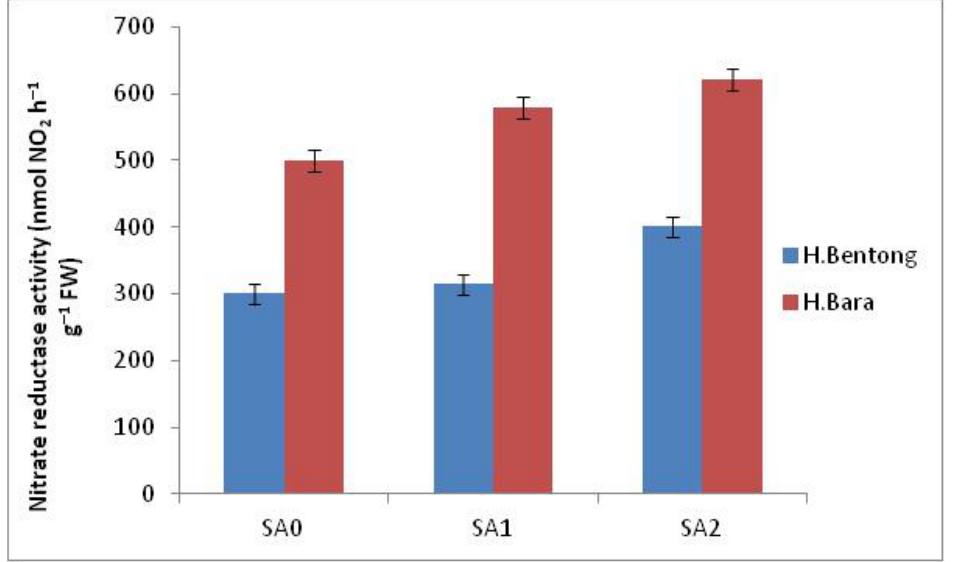
Figure 2. Nitrate reductase activity in Halia Bentong and Halia Bara treated with different concentrations of SA (SA0: control; SA1: 10 –3 M; SA2: 10 –5